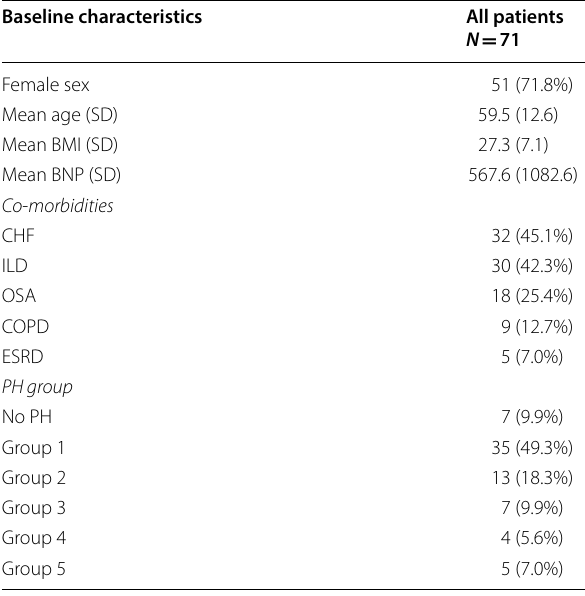
Table 1 Baseline characteristics of patients undergoing right heart catheterization and pre-procedural bedside ultrasound